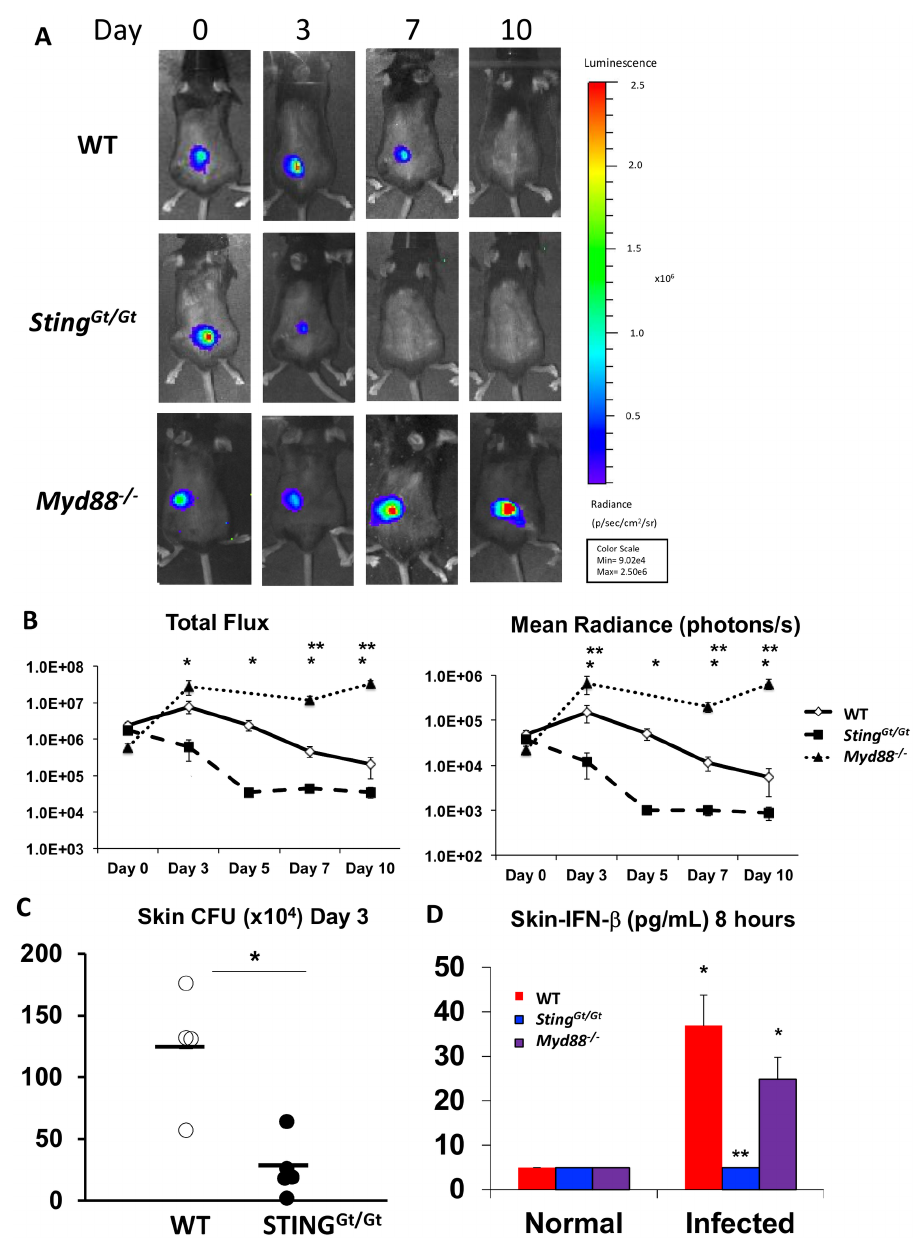
Fig 6. Sting Gt/Gt mice display improve clearanceof S . aureus following cutaneous challenge. (A) Representative WT and Sting Gt/Gt bioluminescent image of one mouse of each strain followingcutaneous injectionof 1x10 6 Xen36 strain of S . aureus .(B) Left panel shows Total Flux over 5 minutes, and Right panel shows Mean Radiance(Photons/second). * denotes p < 0.05by one way ANOVA with Tukey’s test for Sting Gt/Gt mice when comparedto WT mice at each time point and represents an n = 8 mice over two separate experiments. ** denotes p < 0.05by one-wayANOVA with Tukey’s test at each time point for Myd88 -/- mice when comparedto WT mice at each time point and represents an n = 5 for Myd88 -/- comparedto n = 8 WT mice. (C) Confirmation of bioluminescence data by culture of infected skin 3 days followinginfectionconfirms decreased bacterialcounts in the skin of Sting Gt/Gt mice ( * p < 0.05by t test). (D) 8 hours after inoculationinto WT and Sting Gt/Gt mice, skin was harvestedand IFN- β was measuredby ELISA. Sting Gt/Gt mice displayedan impaired ability to induce IFN- β following S . aureus infection(n = 6 WT and Sting Gt/Gt , n = 5 Myd88 -/- ; One way ANOVA with Tukey’s test * denotesp < 0.05comparedto baseline; ** denotedp = 0.003 vs WT infected). All error bars denote standarderror of the